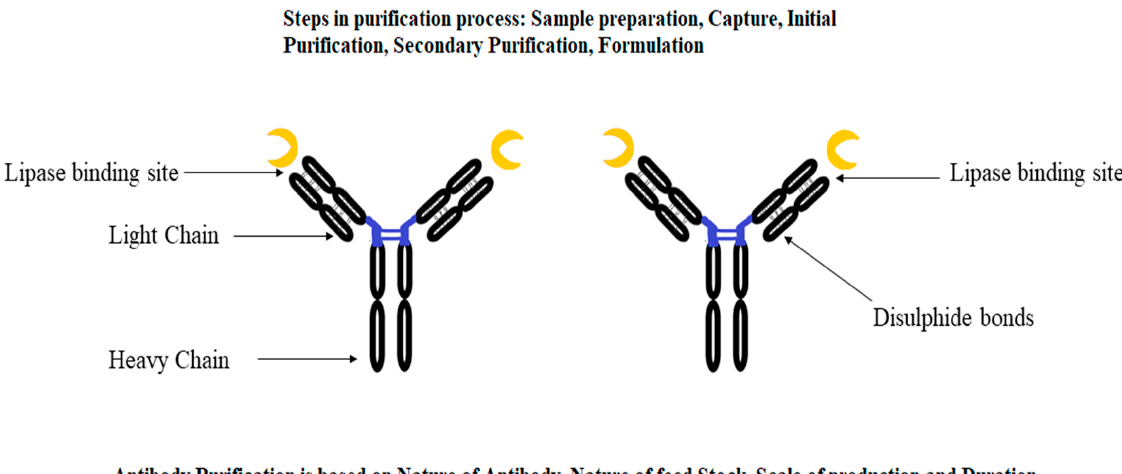
Figure 1. A representative diagram of an antibody used for the immunopurification of microbial lipases.